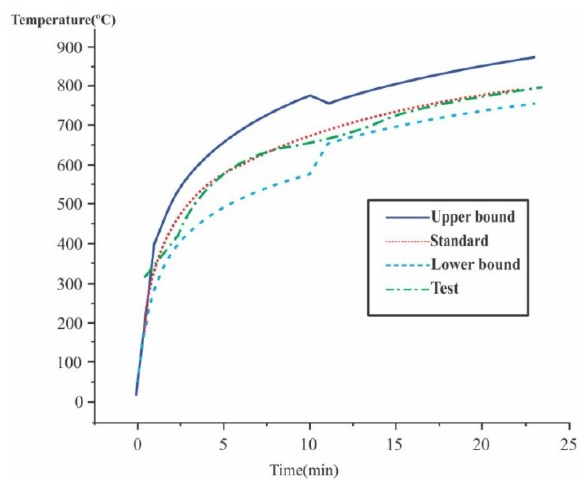
Figure 1. ISO 834 heating curve and furnace heating regime.